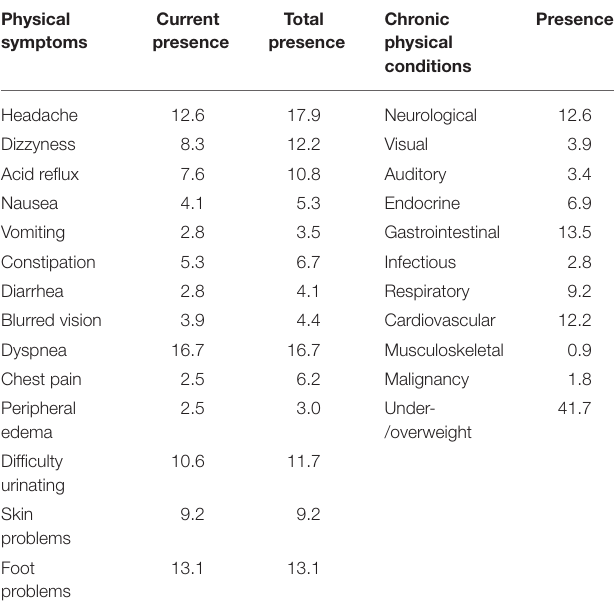
TABLE 2 | Physical health status (in